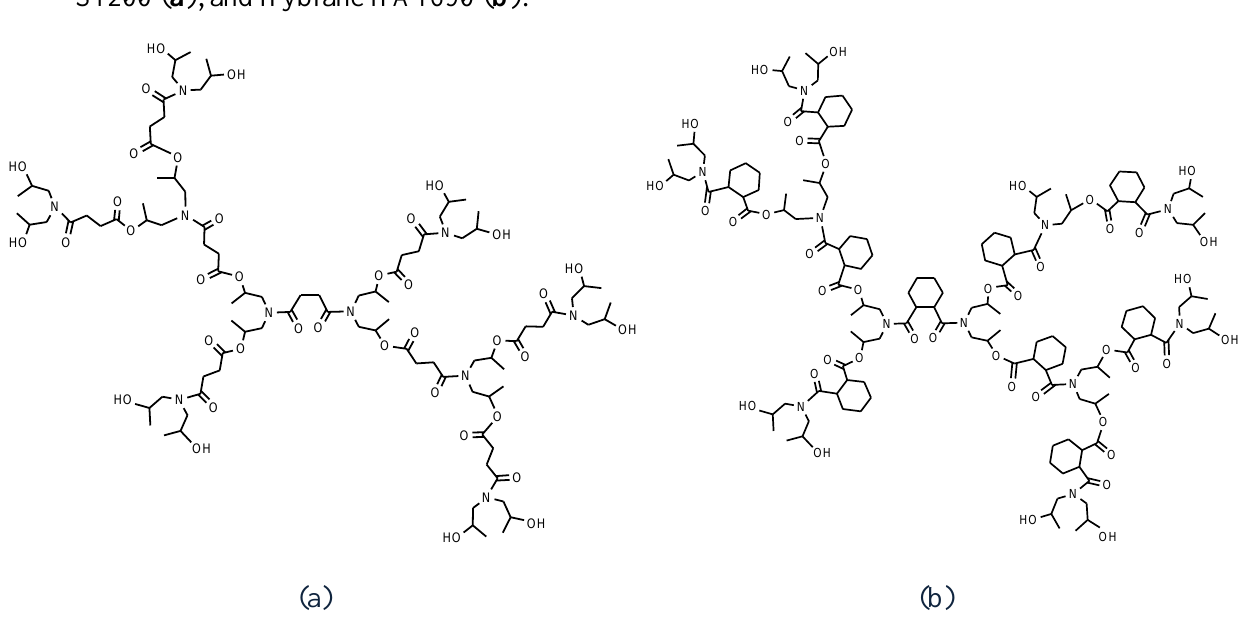
Figure 23. Chemical structures of commercial hyperbranched poly(ester amide)s: Hybrane S1200 ( a ), and Hybrane HA1690 ( b